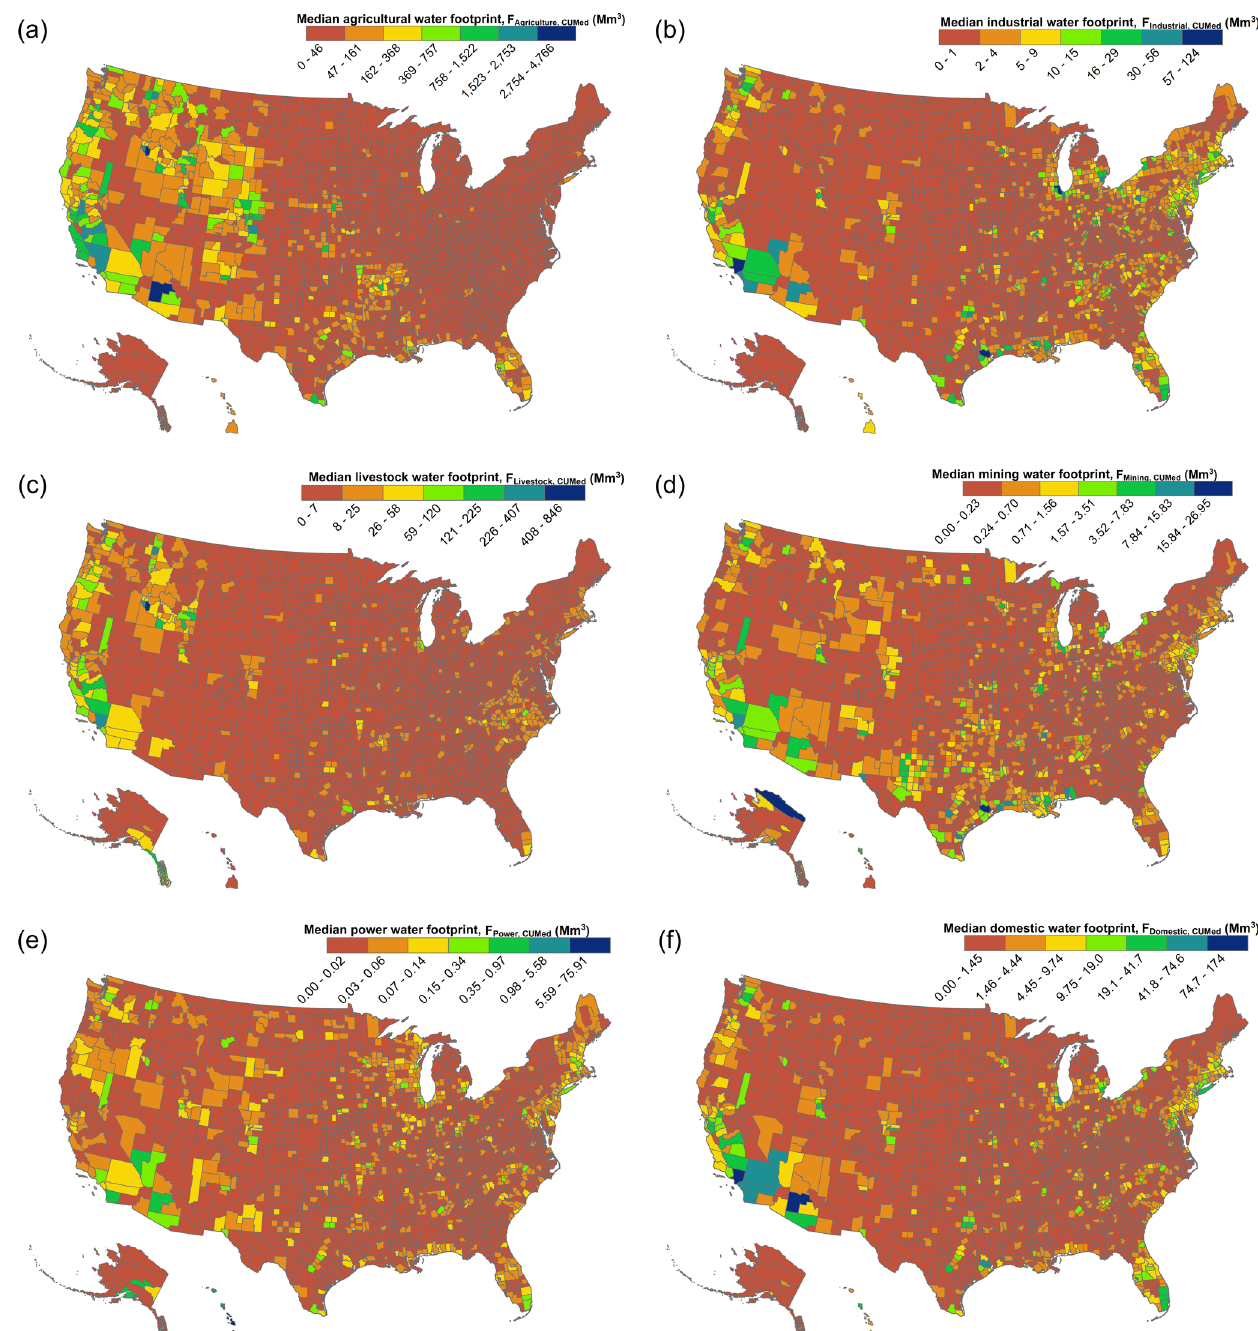
Figure 6. (a) The county-level agricultural blue water footprint of the US. (b) The county-level industrial blue water footprint of the US. (c) The county-level livestock blue water footprint of the US. (d) The county-level mining blue water footprint of the US. (e) The county-level electrical power blue water footprint of the US. (f) The county-level domestic blue water footprint of the